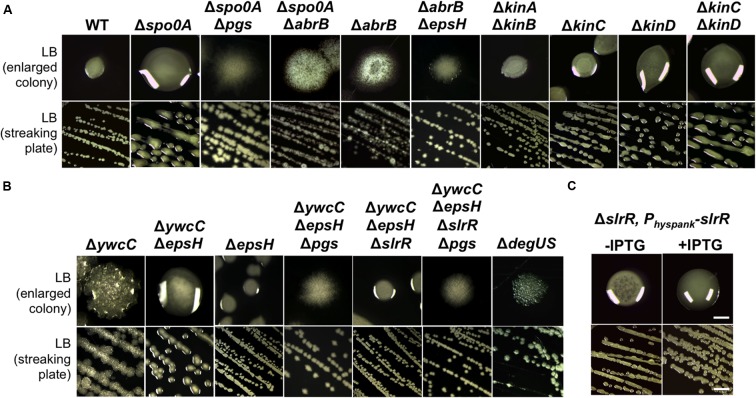
KinC/KinD and YwcC-mediated pathways regulate γ-PGA production in B. subtilis.(A) Shown is the colony mucoidy phenotype on LB agar media by various mutants in 3610. Strains used in this assay include 3610 (WT), RL4573 (ΔkinAΔkinB), RL4262 (ΔkinC), RL4569 (ΔkinD), RL5273 (ΔkinCΔkinD), YY214 (Δspo0A), YY233 (Δspo0A ΔepsH), YY208 (Δspo0A ΔabrB), YC668 (ΔabrB), and YY201 (ΔabrB ΔepsH). Cells were streaked out on LB plates and incubated for 12 h at 37°C before pictures were taken. Both the streaking plates and enlarged colonies were shown. (B) Shown in (B) are the same as in (A) except that different mutants of 3610 were applied. Strains used here include 3610 (WT), YC295 (ΔywcC), YC299 (ΔywcC ΔepsH), RL3852 (ΔepsH), YY198 (ΔywcCΔepsHΔpgs), YY199 (ΔywcCΔepsHΔslrR), and YY200 (ΔywcCΔepsHΔslrR Δpgs), and RL4637 (ΔdegSU). (C) The colony mucoidy phenotype by a ΔslrR derivative (FC100) expressing slrR from an IPTG-inducible hyperspank promoter at the amyE locus. Scale bars in the panels showing the streaking plate and the enlarged colonies represent 5 and 1 mm in length, respectively. This applies to similar panels in this figure.